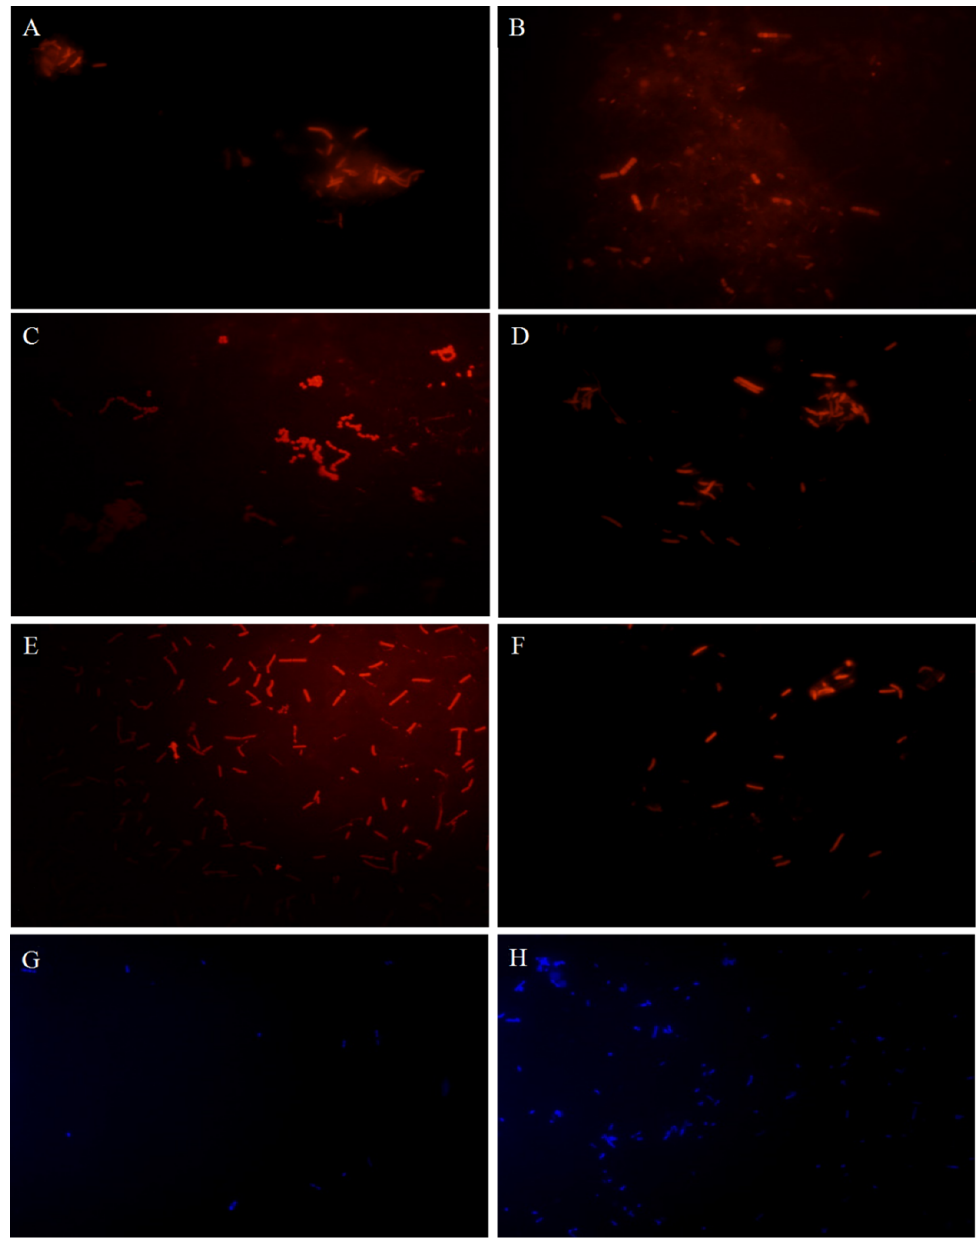
Figure 2. Fluorescence in situ hybridization (FISH) results of anaerobic incubation (12 h) with LHEPS as substrate using 16S rRNA-targeted oligonucleotide probes ((Bif164 ( A ), Lab 158 ( B ), Str 493 ( C ), Bac 303 ( D ), EC 1531 ( E ), His 150 ( F ), and DAPI ( G , H )).